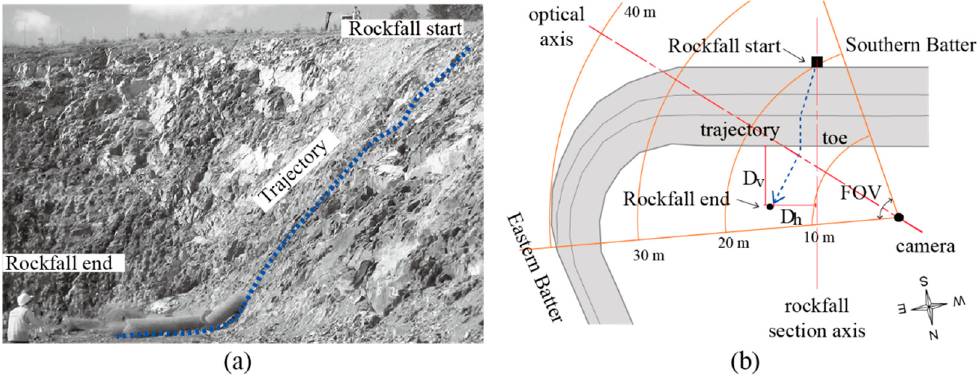
Figure 3. Overview of the study area with the rockfall test location: ( a ) a captured image from Zoom Q2 HD handy video at the test location; ( b ) illustration of the plan view of field test.